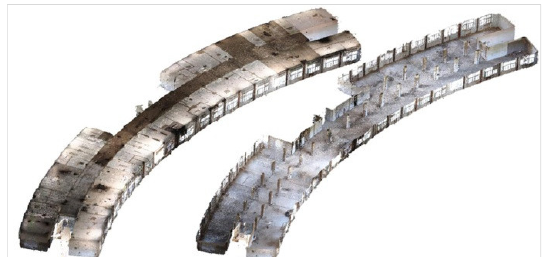
Figure 3: Axonometric view of the point cloud of a standard level. On the left the total result, on the right the sectioned result in the horizontal plane.